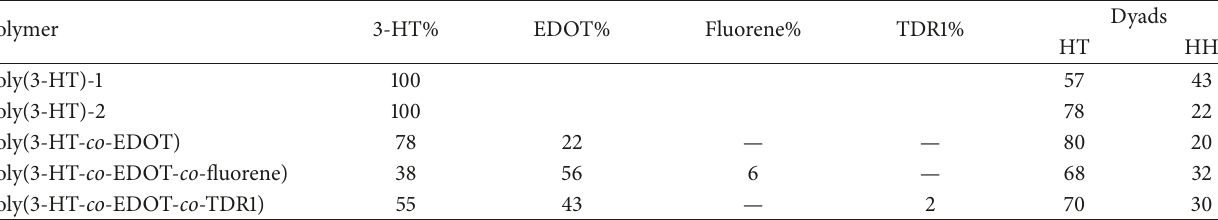
Table 1: Percentages of the incorporated monomers into the polymers and their regioregularity obtained by 1 H NMR. Polymer